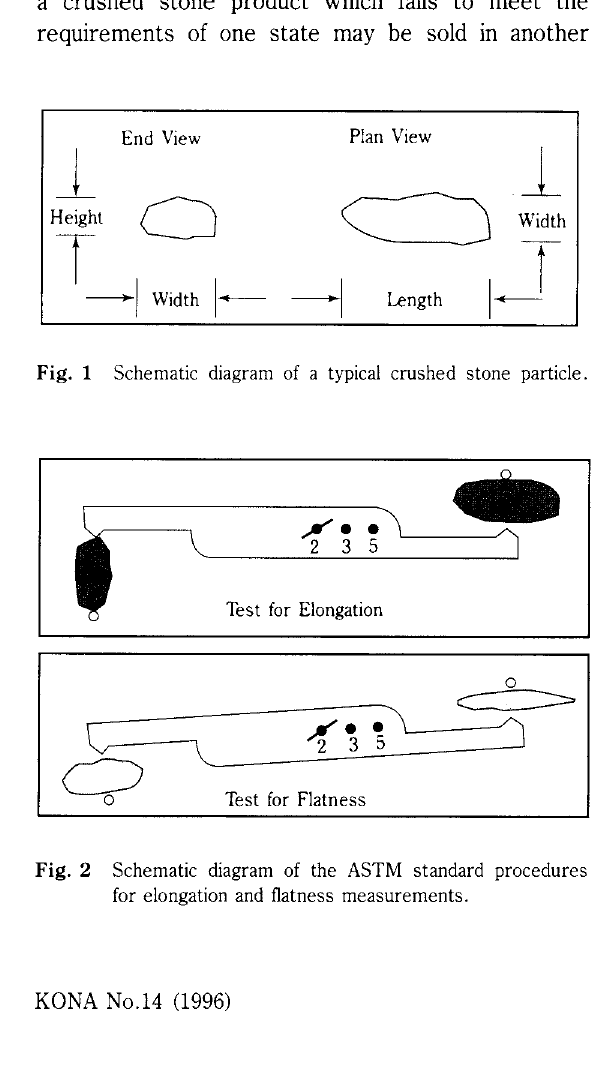
Fig. 2 Schematic diagram of the ASTM standard procedures for elongation and flatness